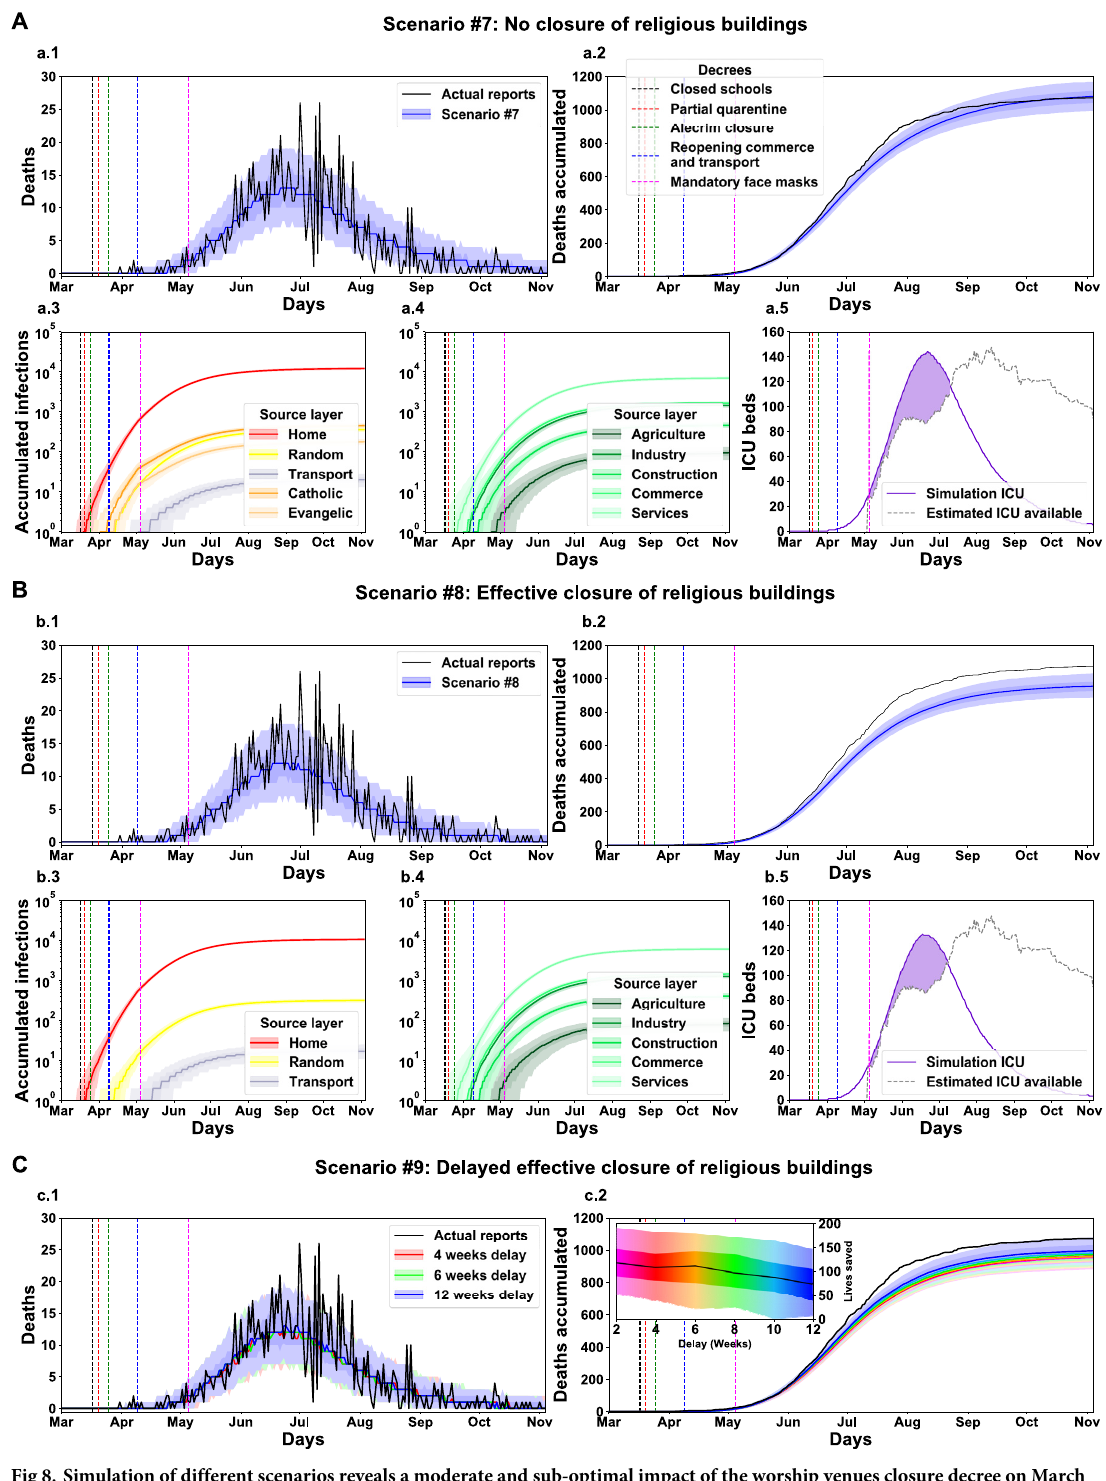
Fig 8. Simulation of different scenarios reveals a moderate and sub-optimal impact of the worship venues closure decree on March 25th, 2020. Results for a baseline scenario altered for the condition that worship venues were never closed (#7, A), closed effectively (#8, B) and closed effectively with a delay from the original decree’s publication date (#9, C). The total number of lives saved in each scenario is the difference between the reported number of deaths and the simulation outcome. For scenario #9, the delay in weeks is colour-coded, and the additional number of lives saved is shown in an insert. See Fig 5 for panel